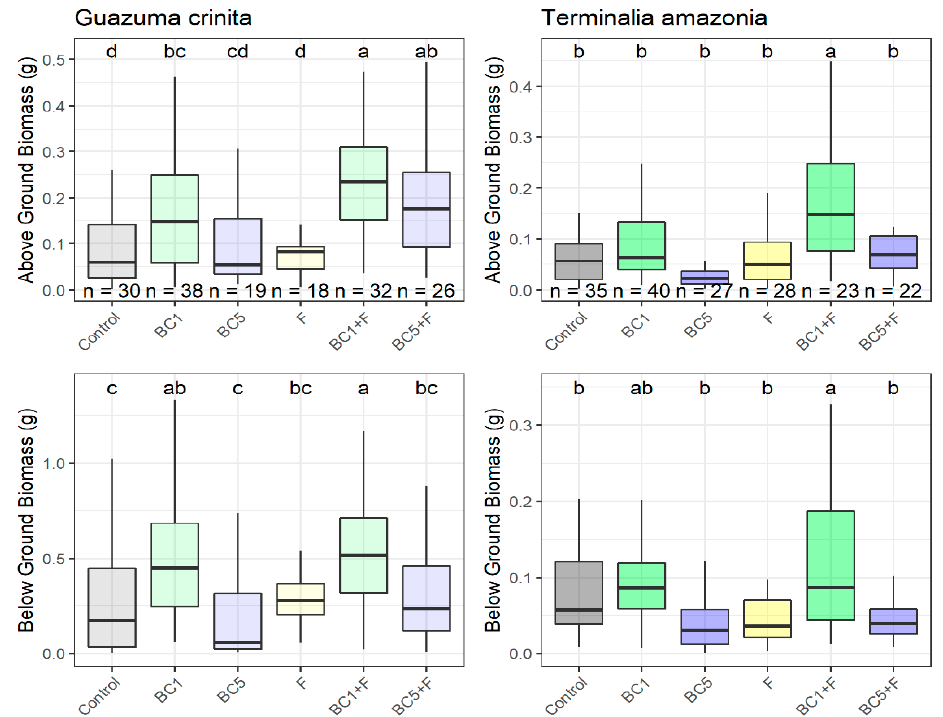
Figure 3. Species dry above- and below-ground biomass across six di ff erent biochar and fertilization treatments (BC1 = Biochar 1 kg / plant; BC1 + F = Biochar 1 kg / plant + Fertilizers; BC5 = Biochar 5 kg / plant; BC5 + F = Biochar 5 kg / plant + Fertilizers; Ctrl = Control; F = Fertilizers). Di ff erent letters above each plot represent significant statistical di ff erences, ANOVA + TUKEY post hoc ( p < 0.05). The end of the upper (lower) whisker represent the largest (smallest) value within 1.5 times interquartile range above (below) 75th (25th) percentile, as defined by the ggplot2 package of R software version (3.5.1) [36].